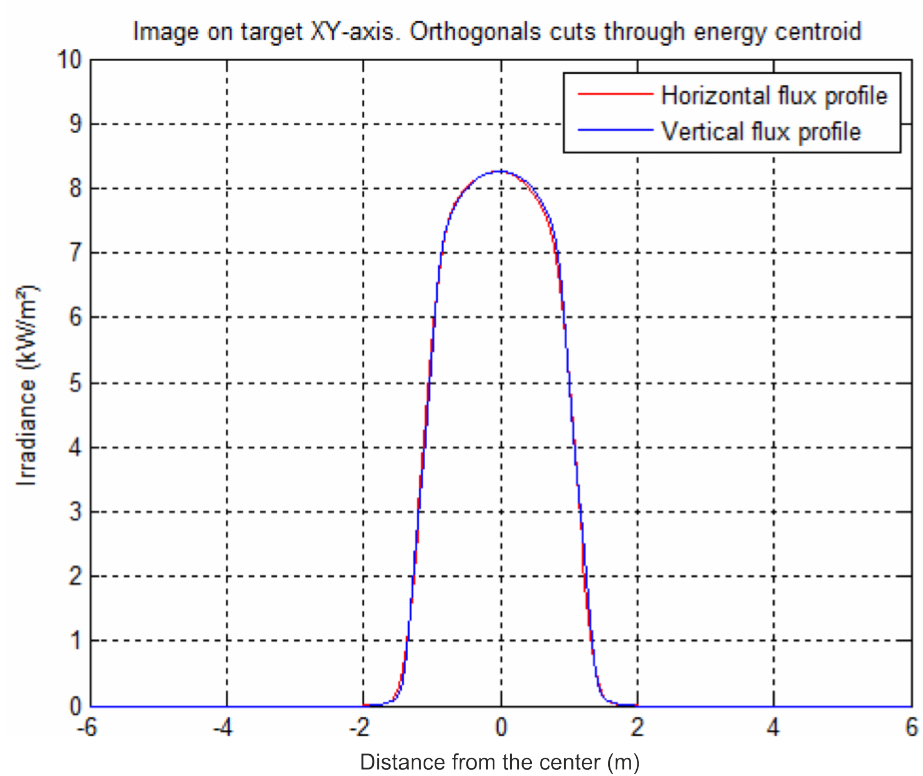
Figure 8. Vertical and horizontal flux profile on the target (9 March 2017 at 14:02